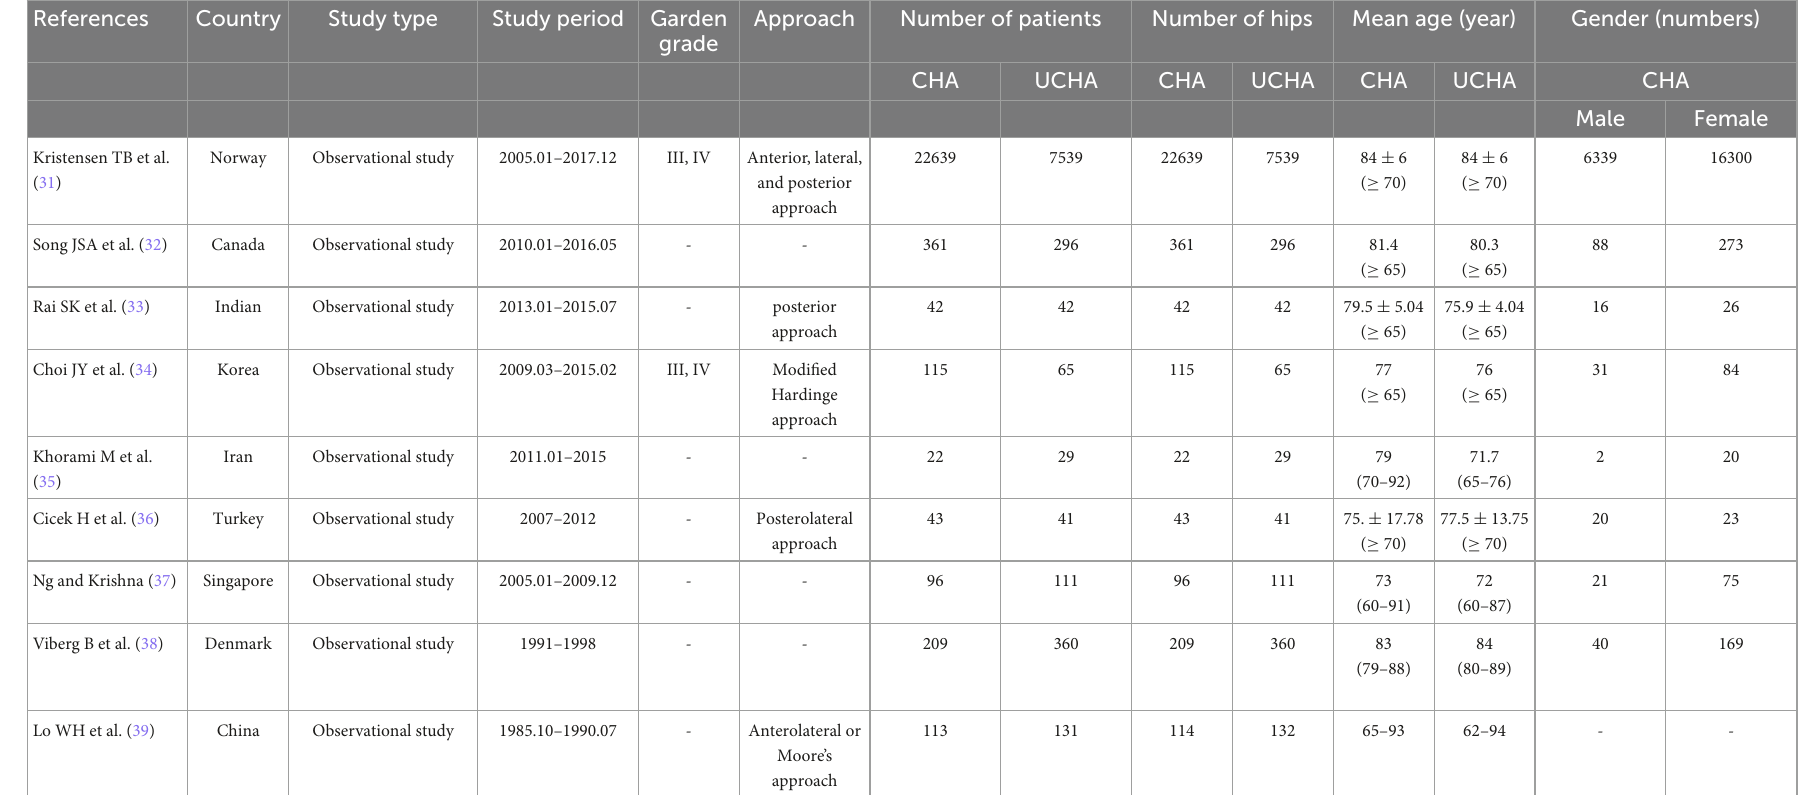
TABLE 2 Baseline characteristics of observational studies included in